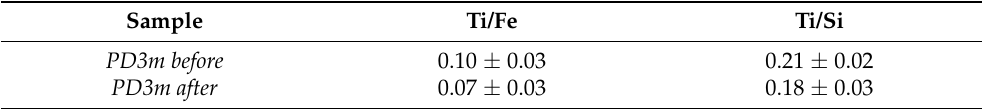
Table 4. Ratios between the atomic concentration percentages measured by EDS on the PD3m coatings before and after the photocatalytic